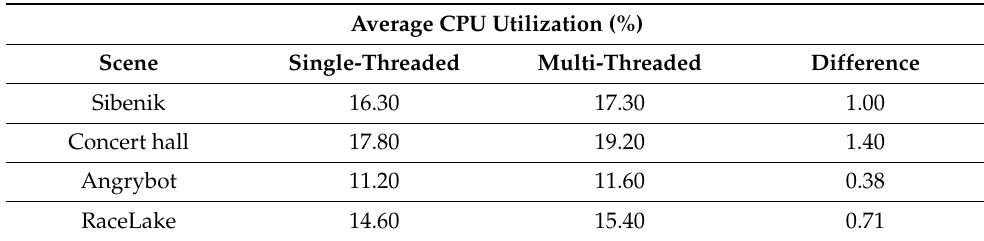
Table 3. Average CPU utilization comparison of single-threaded and multi-threaded algorithms.